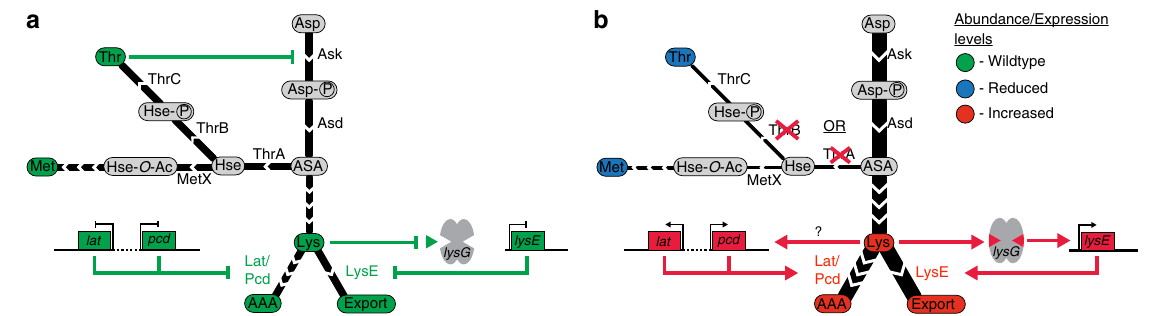
Fig. 7 Schematic of aspartate pathway regulation. a Wildtype levels of threonine lead to proper feedback regulation of Ask, and subsequent wildtype levels of lysine and its degradation (Lat/Pcd) and export (LysE) pathway enzymes and metabolites. b Disruption of threonine biosynthesis causes derepression of Ask leading to an accumulation of Lysine, which in turn activates the lysine degradation and export pathways. Nomenclature: Metabolites in rounded boxes: Asp: aspartate, Asp-P: aspartate-phosphate, ASA: aspartate-semialdehyde, Hse: Homoserine, Hse-P: homoserine-phosphate, Thr: Threonine, HsE- O-Ac: O-acetyl-homoserine, Met: methionine, Lys: lysine, AAA: aminoadipate, Enzymes: Ask: aspartate kinase, Asd: aspartate semidaldehyde dehydrogenase, ThrA: homoserine dehydrogenase, ThrB: threonine kinase, ThrC: threonine synthase, MetX: homoserine O-acetyl-transferase, LysE: lysine exporter, Lat: lysine aminotransferase, Pcd: aminoadipate-semialdehyde dehydrogenase. Genes in square boxes. Color coding: green: wildtype levels, blue: reduces levels, red: increased